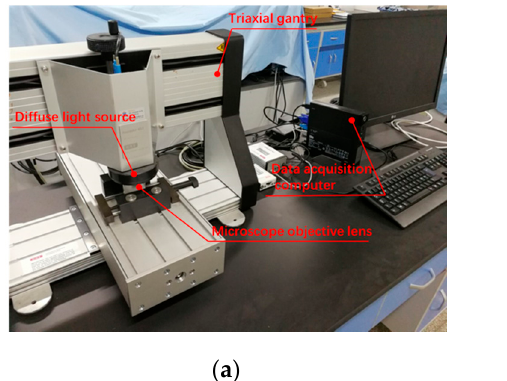
Figure 3. Ultrasonic direct-penetration method.